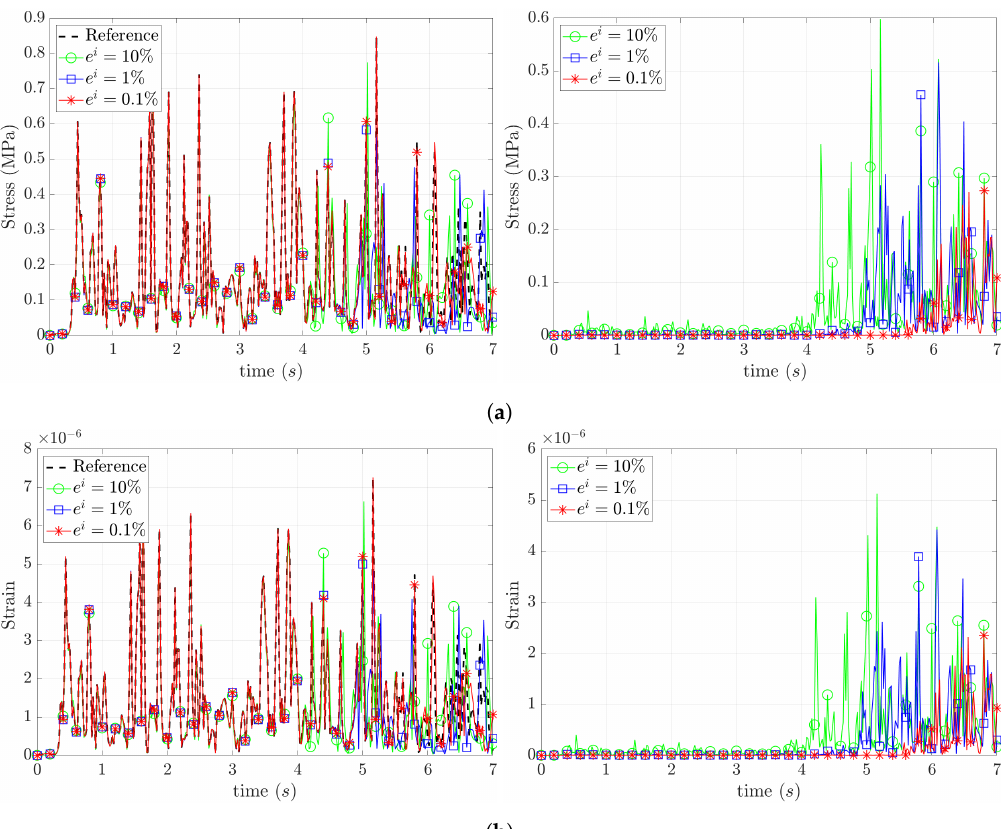
Figure 8. The von Mises stress and the von Mises strain of node A for the error tolerance e i = 10%,1%, and 0.1%. ( a ) The von Mises stress of Node A and its absolute error; ( b ) the von Mises strain of Node A and its absolute error.